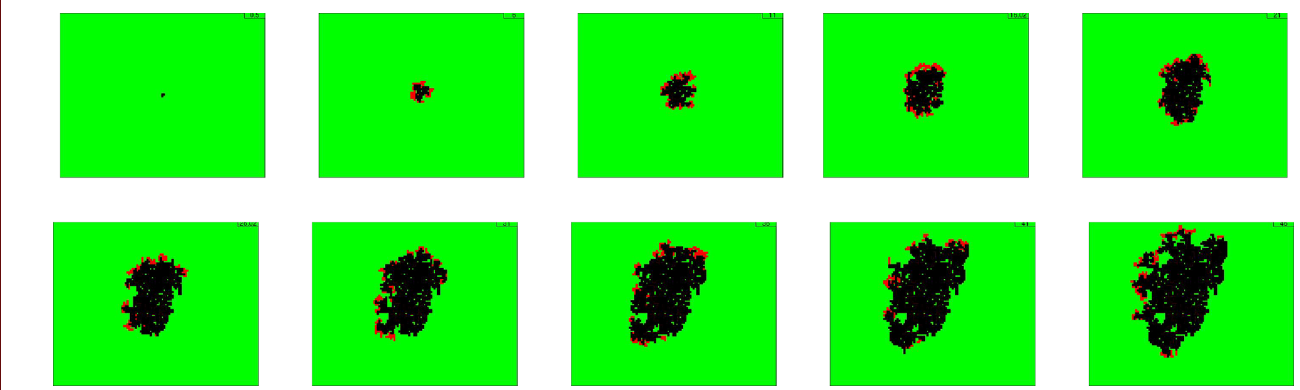
Figure 3. A simulation run of the model fit to the observed data from Figs. 1 and 2. Colour coding is the same as described in Fig. 2.